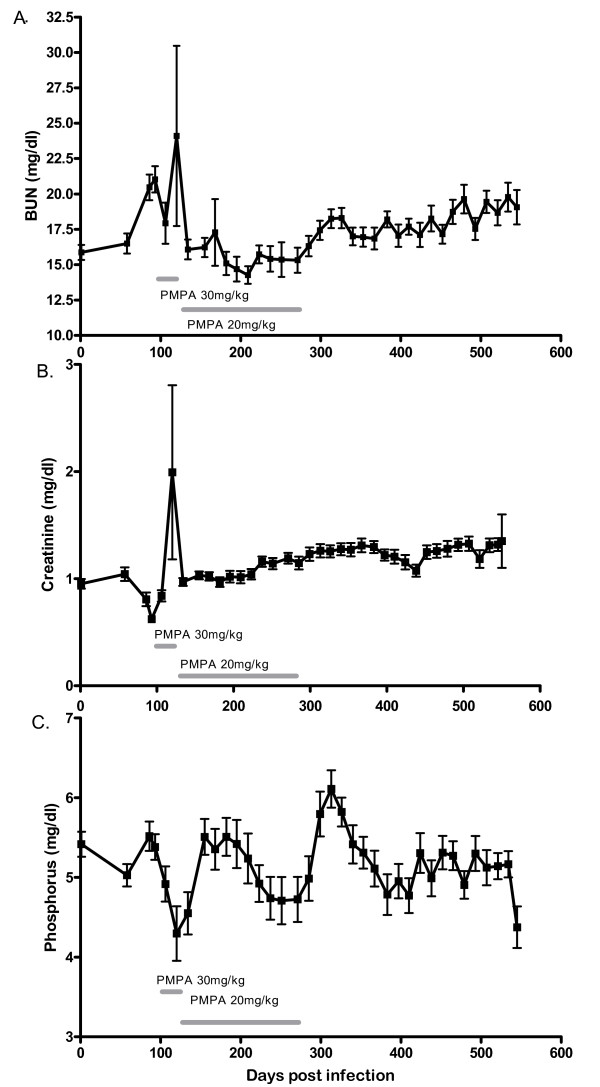
Longitudinal changes in serum BUN, creatinine and phosphorus following SIV infection and ART treatment. Longitudinal changes in Blood Urea Nitrogen, creatinine, and phosphorus in the serum of ART-treated, SIV-infected rhesus macaques. Shown are mean and standard deviation for a period of 79 weeks after SIV infection. Durations of PMPA treatment with the 30 mg/kg and 20 mg/kg dose are indicated.